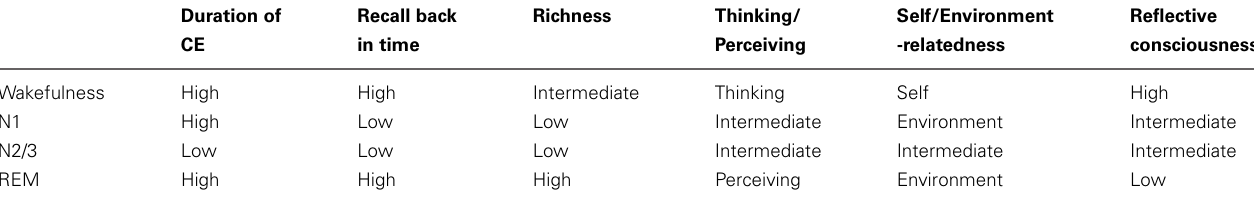
Table 2 | Summary of characteristic features of conscious experiences across stages.